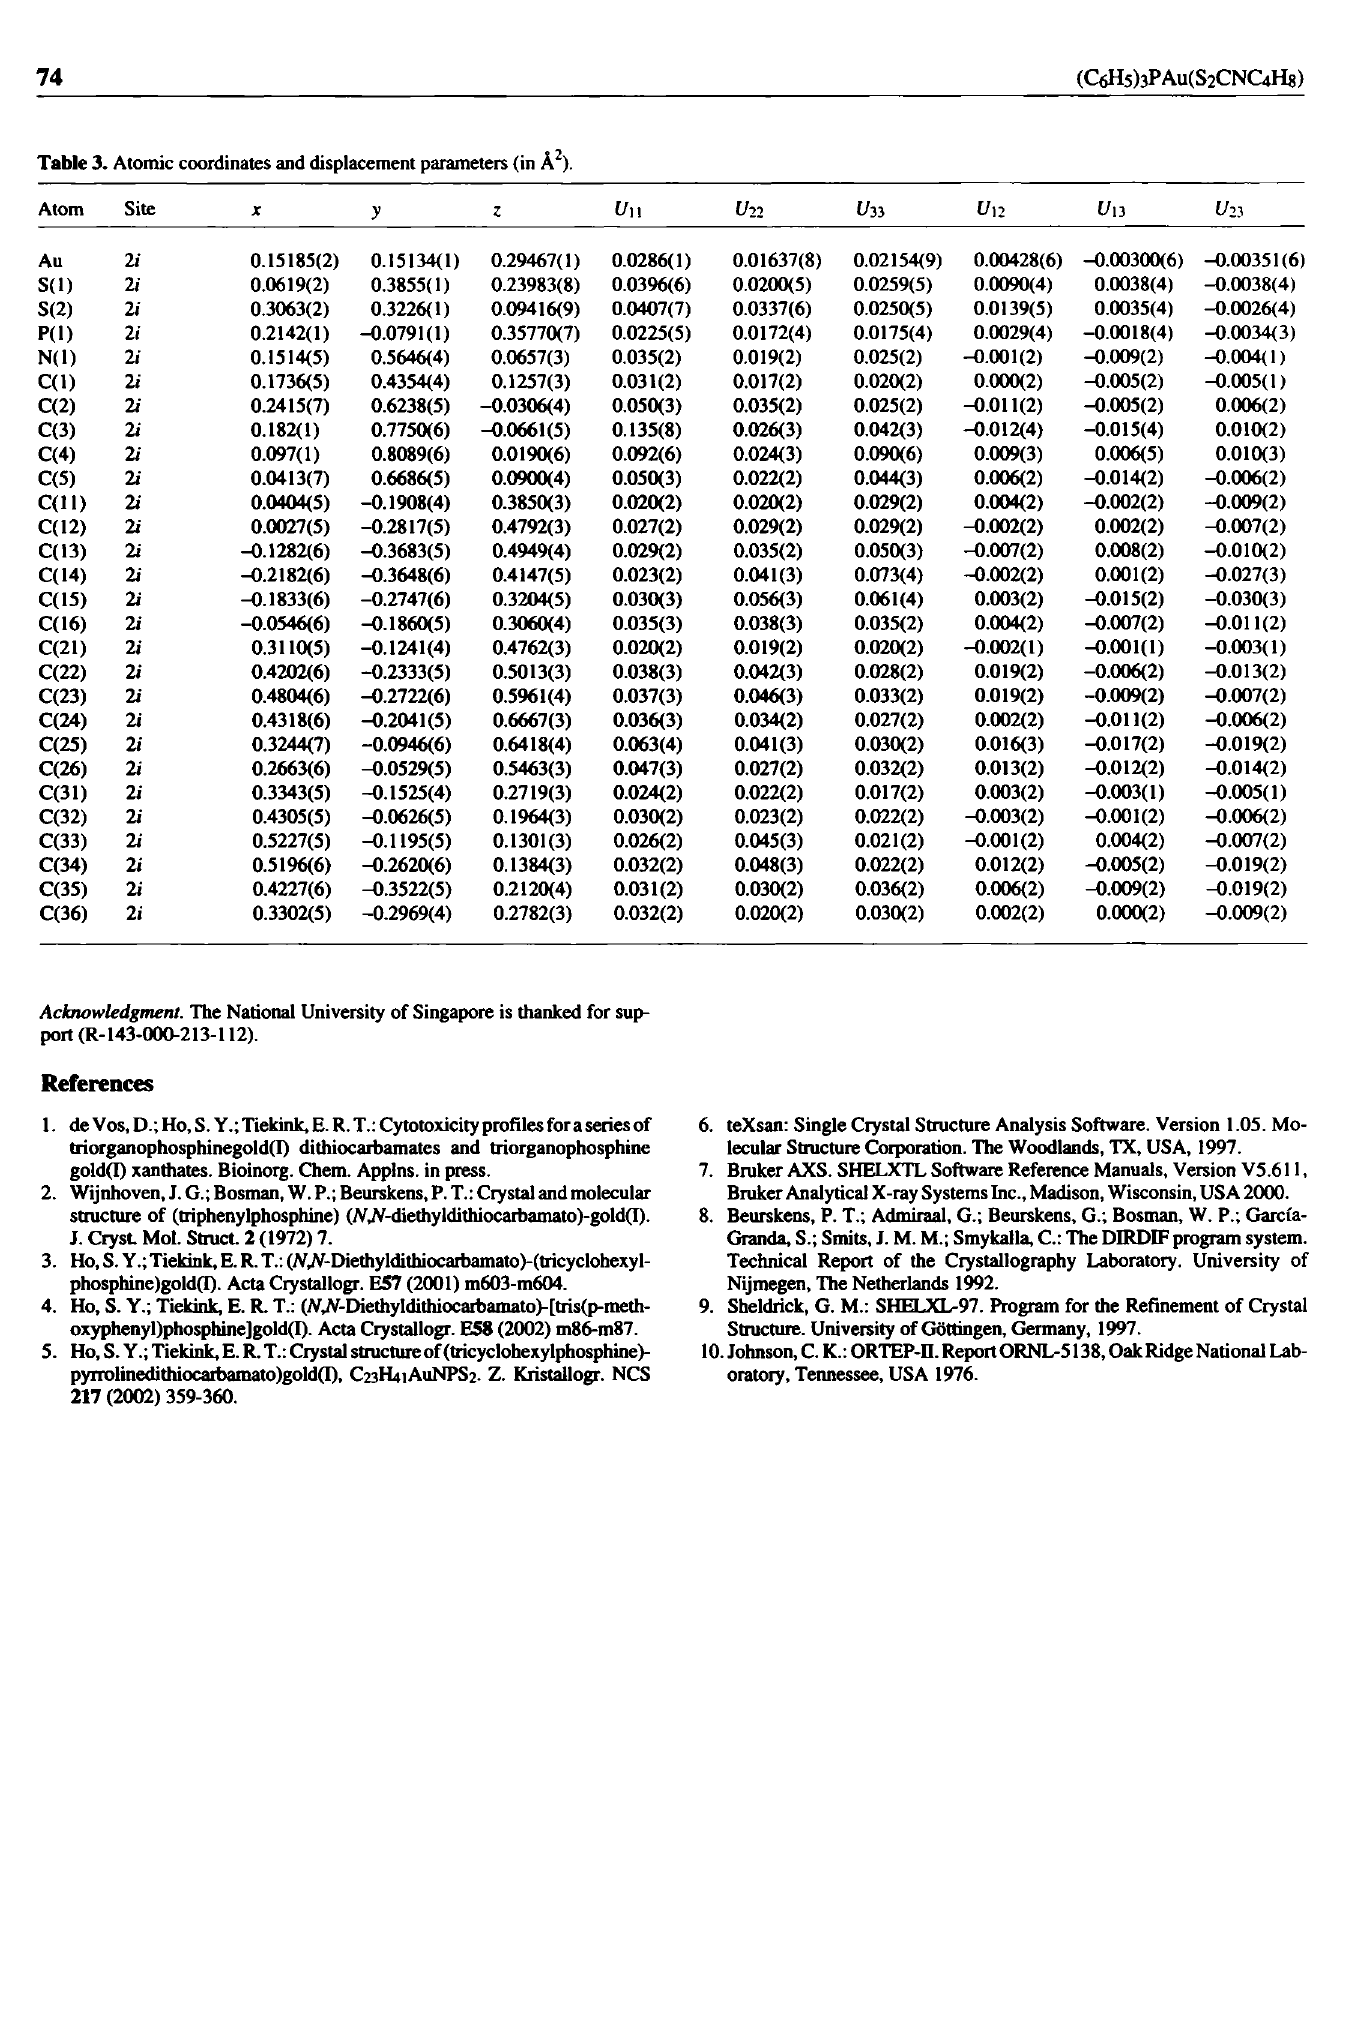
Table 3. Atomic coordinates and displacement parameters (in Â 2